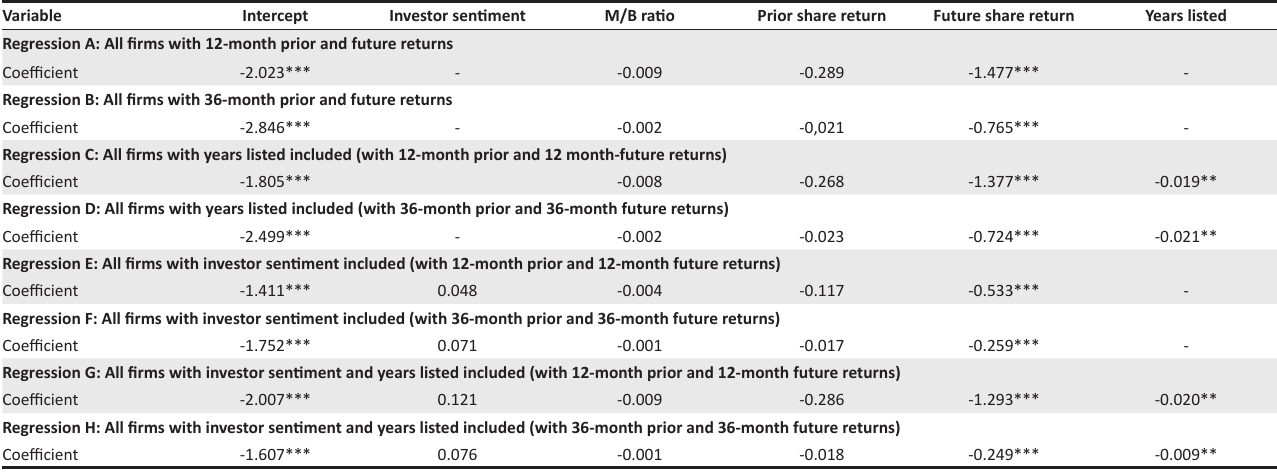
TABLE 2: Regression analysis on the decision to conduct secondary equity